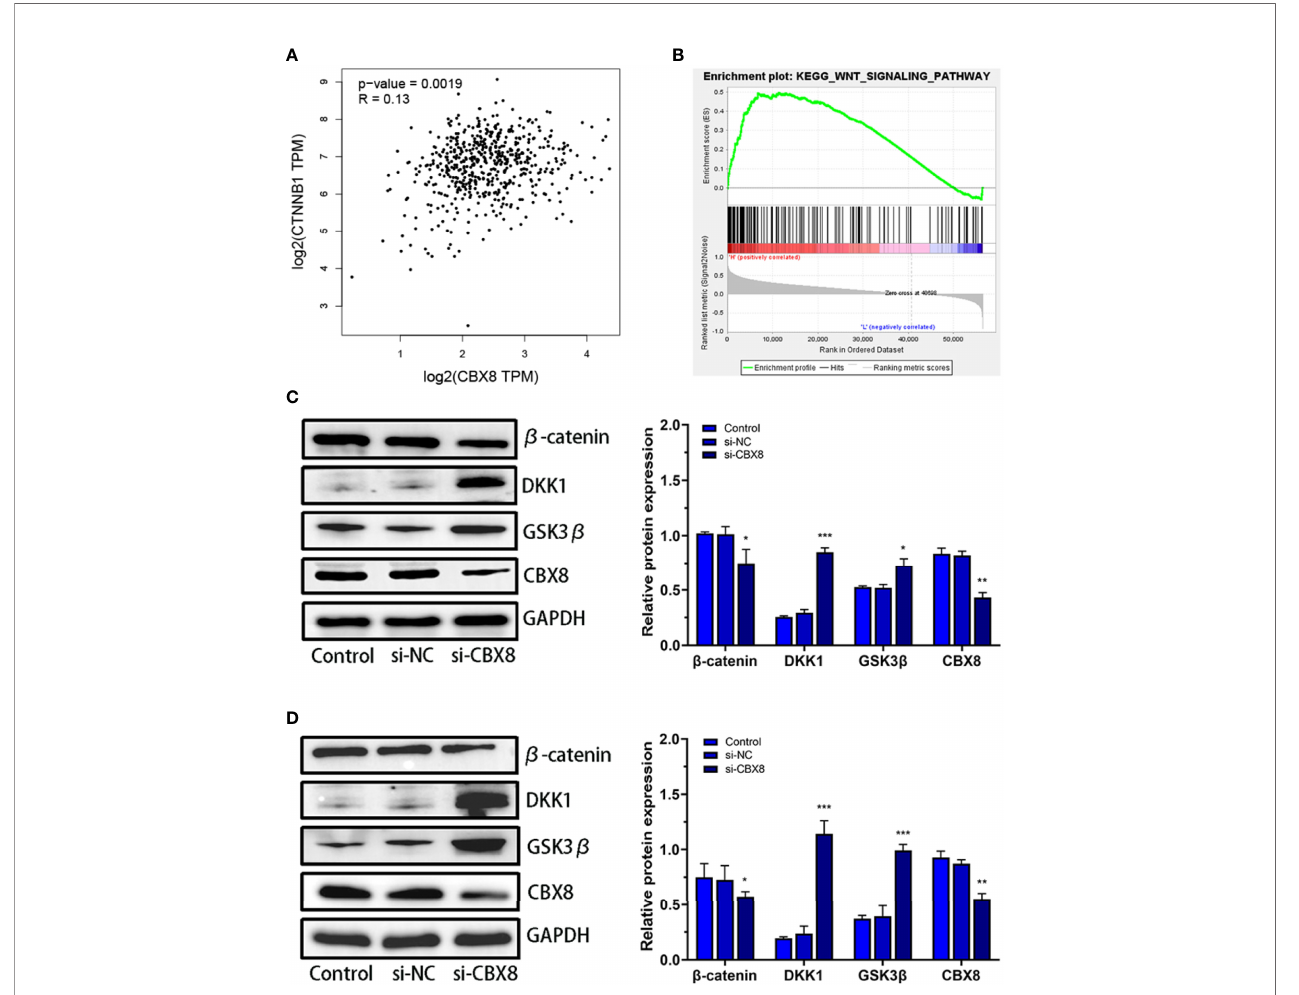
FIGURE 5 | Effect of CBX8 knockdown on the Wnt/ b -catenin signaling pathway. (A) Correlation analysis between CBX8 and CTNNB1 in the TCGA CO-AD dataset. (B) GSEA showed that CBX8 was enriched in the Wnt/ b -catenin signaling pathway in LSCC. (C, D) The expression levels of b -catenin, DKK1 and GSK3 b in AMC- HN-8 and Hep2 cells were detected by Western blotting and semiquantitative analysis. Each assay was repeated at least three times. Data from one representative experiment is presented as Mean ± SEM (*P < 0.05, **P < 0.01, ***P <